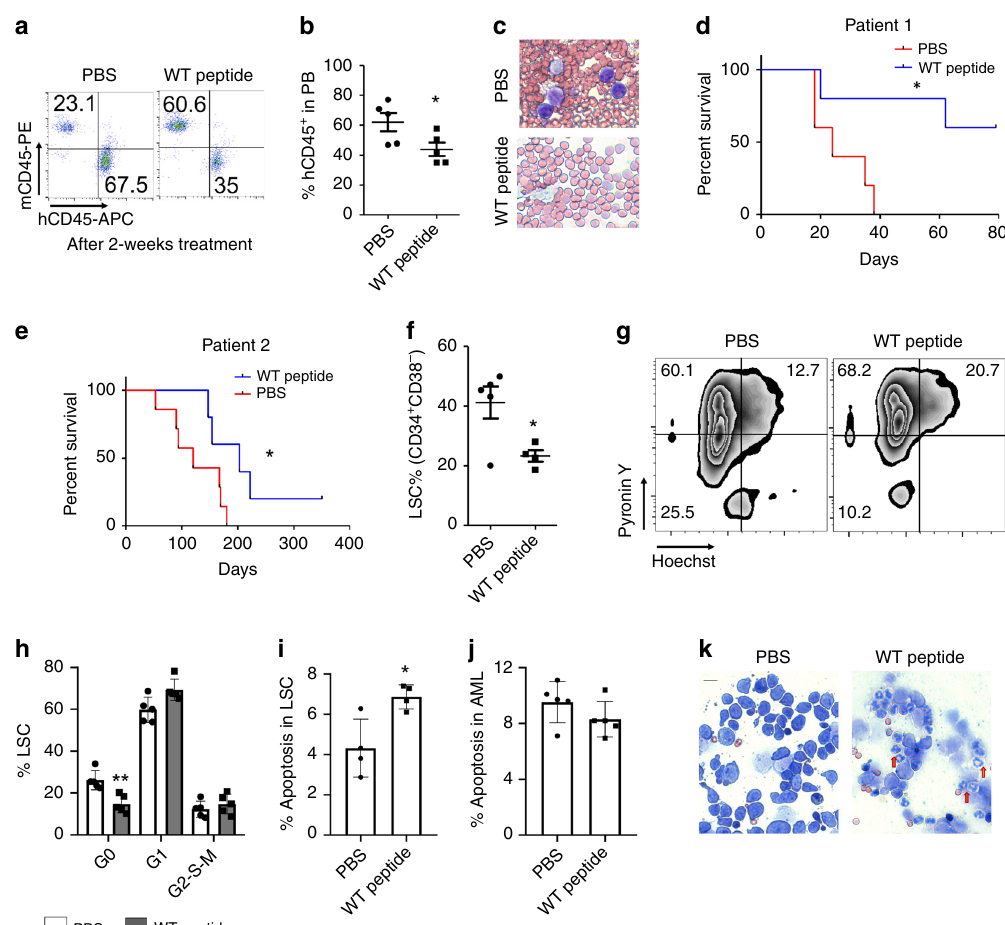
Fig. 9 Inhibition of FOXM1 suppressed primary LSCs from MA9 patients. a, b Flow cytometry analyzing human AML cells ratio in PB cells from patient- derived xenograft (PDX) mice. Gating strategy is shown in ( a ) and summary data are presented in ( b ). c Wright-Giemsa-stained PB cells from PDX mice are shown, bar = 20 μ M. d, e Kaplan – Meier survival curve of PDX mice for two patient samples, n = 5 mice for each group in ( d ), n = 5 mice for PBS or n = 7 mice for WT peptide treatment group. f Flow cytometric analysis of LSC ratio (CD34 + CD38 − ) in PDX mice ( n = 5). g, h Flow cytometric analysis of cell cycle of LSC in PDX mice. Gating strategy is shown in ( g ). The cells were stained with DNA Dye Hoechst and RNA Dye PyroninY. Double negative population indicated the G0 phase/quiescence, n = 5 mice for each group. i Flow cytometric analysis of apoptosis rate of LSCs in PDX mice, n = 4 mice for each group. j Flow cytometric analysis of apoptosis rate of total leukemia cells in PDX mice, n = 5 mice for each group. k Wright-Giemsa staining of human AML cells collected from PDX mice. Differentiated cells indicated by red arrow were present in WT peptide treatment mice. * p < 0.05, ** p < 0.01, *** p < 0.001, bar = 20 μ M, mean ± s.d., t -test or Log-rank (Mantel – Cox) Test for survival curve. The PDX mice were reconstituted with leukemia cells from primary MLL-r AML patients. All PDX mice were treated with WT peptide or vehicle PBS. Source data are provided as a Source Data